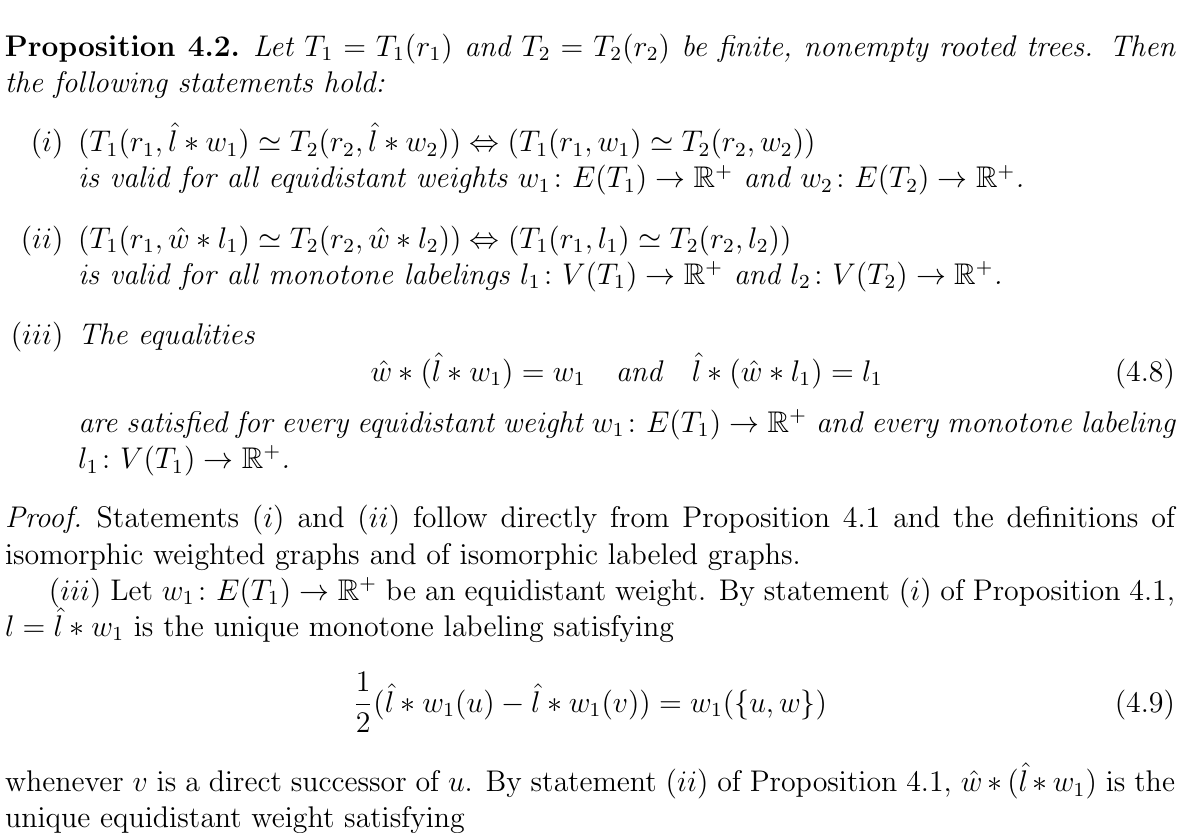
Figure 8: The weight w and labeling l satisfy (4.4) whenever v is a direct successor of u